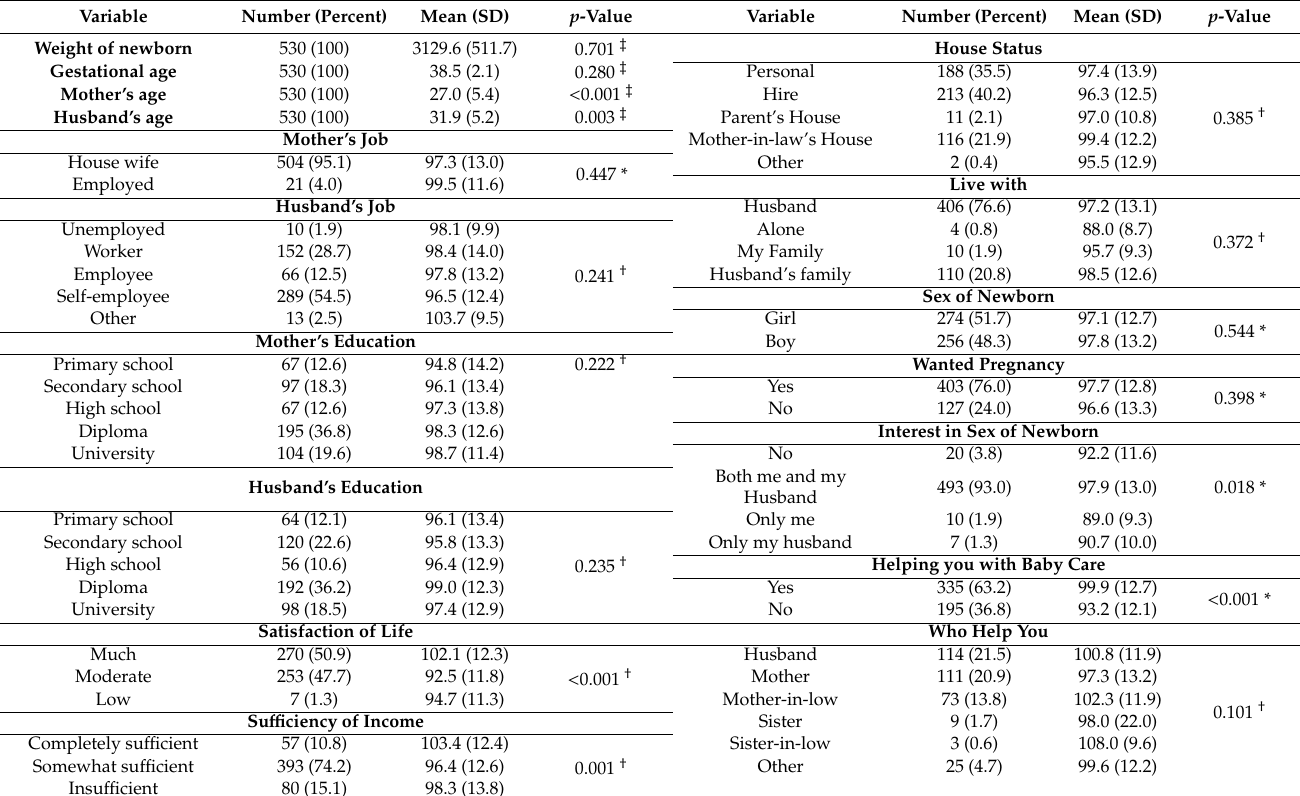
Table 1. The Relationship between socio-demographic and obstetrics characteristics with maternal functioning in women referred to health centers of Tabriz, Iran, 2019 ( n =